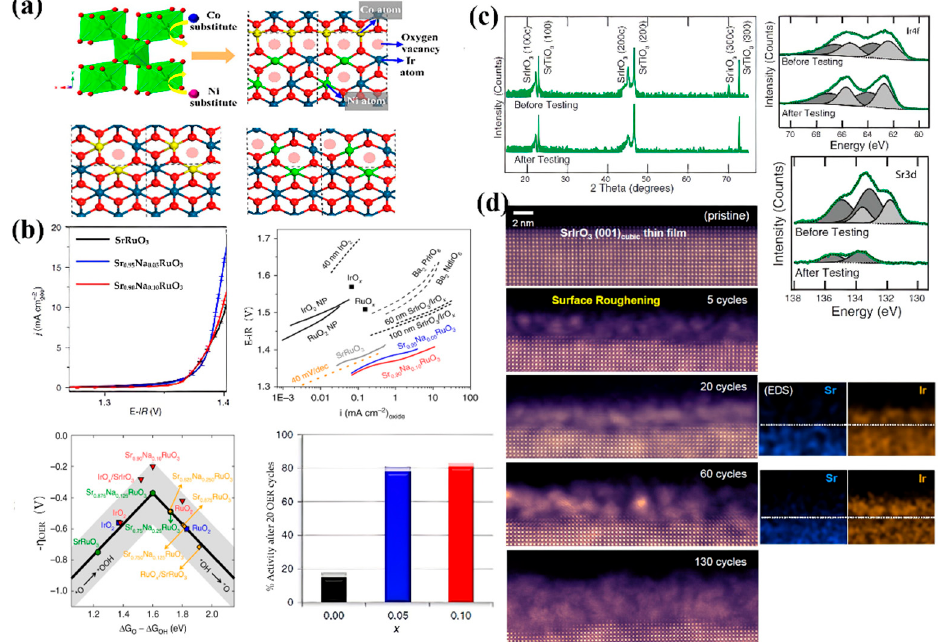
Figure 4. ( a ) Polyhedral model of IrO 2 being doped with Ni and Co [83]. ( b ) Enhanced OER activity and durability of SrRuO 3 by Na doping [86]. ( c ) XRD and XPS spectra of a SrIrO 3 film before and after 30 h of OER testing [87]. ( d ) High-angle annular dark-field (HAADF) images of the surface structural evolution of a SrIrO 3 film during the OER [89].